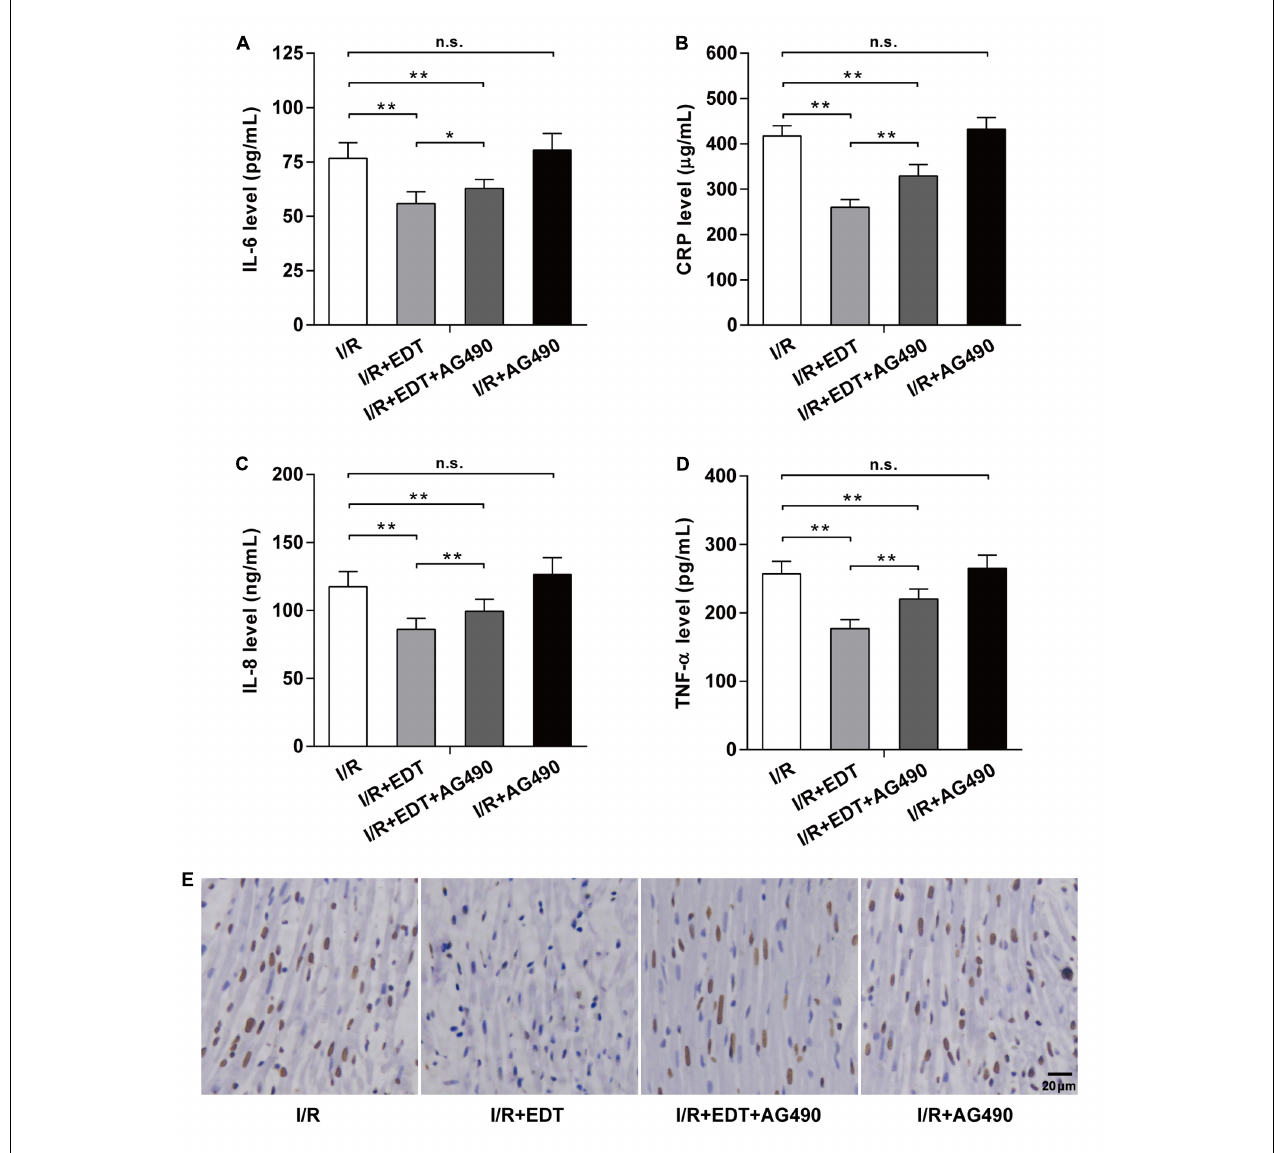
FIGURE 6 | AG490 abolishes the effect of EDT on inflammatory response and cardiomyocyte apoptosis in global myocardial I/R. The effect of EDT on IL-6 (A) , CRP (B) , IL-8 (C) , and TNF- α (D) levels in cardiac tissues were measured after co-treatment with AG490. (E) The cardiomyocyte apoptosis in cardiac tissues was examined after co-treatment with EDT and AG490. Brown staining of the nucleus indicates cell apoptosis. Scale bar: 20 µ m. n = 8 for each group. All data are the mean ± SD. ∗ P < 0.05, ∗∗ P <